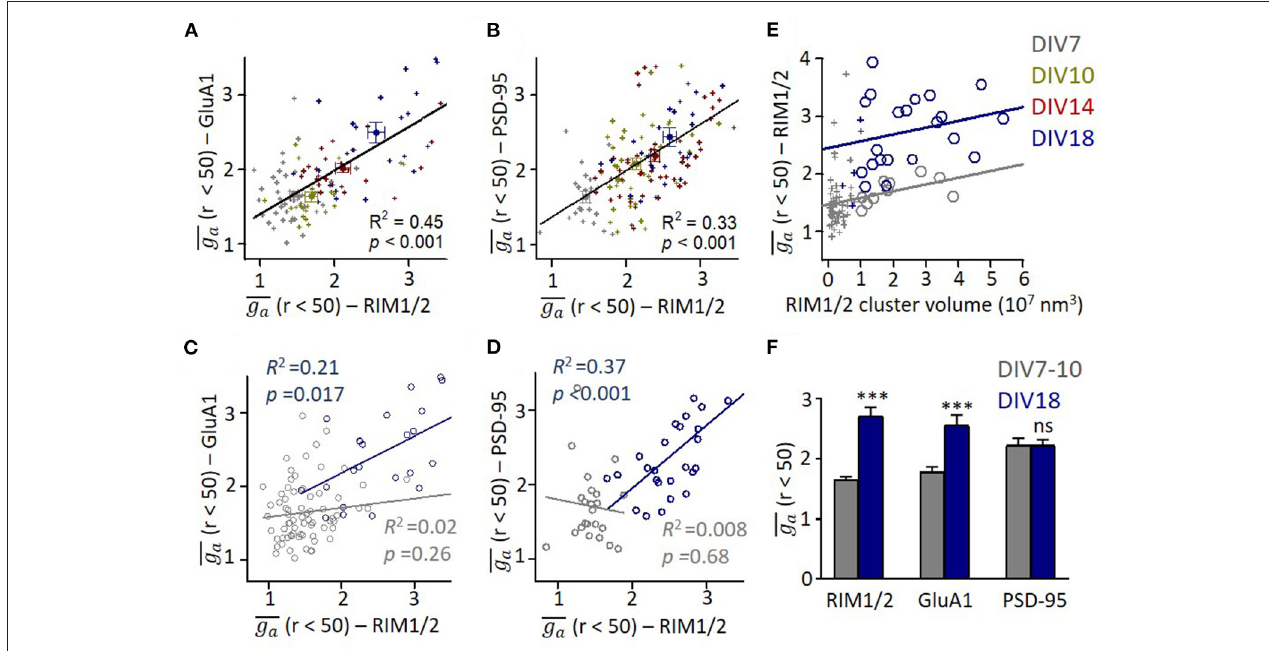
FIGURE 3 | Correlation between presynaptic and postsynaptic protein heterogeneity in mature synapses. (A,B) Scatter plots for heterogeneity of GluA1 (A) and PSD-95 (B) against that of RIM1/2. All data points across all developmental stages could be fitted with linear functions as shown with lines. (C,D) Linear regressions of the relationships between heterogeneity of GluA1/PSD-95 and RIM1/2 at DIV7 (gray) and DIV18 (dark blue). (E) Relationship between heterogeneity and cluster volume of RIM1/2 at DIV7 (gray) and DIV18 (dark blue). Data points with cluster volume > 1 × 10 7 nm 3 were fitted with linear functions. It is noted that g a of immature synapses was significantly lower than that of matured synapses. (F) Averaged g a of synapses with cluster volume of 1–4 × 10 7 nm 3 for immature (DIV7-10) and mature synapses (DIV18). Also refer to Supplementary Figure 3 for more details. *** p < 0.001, t-test. All experiments were repeated ≥ 3